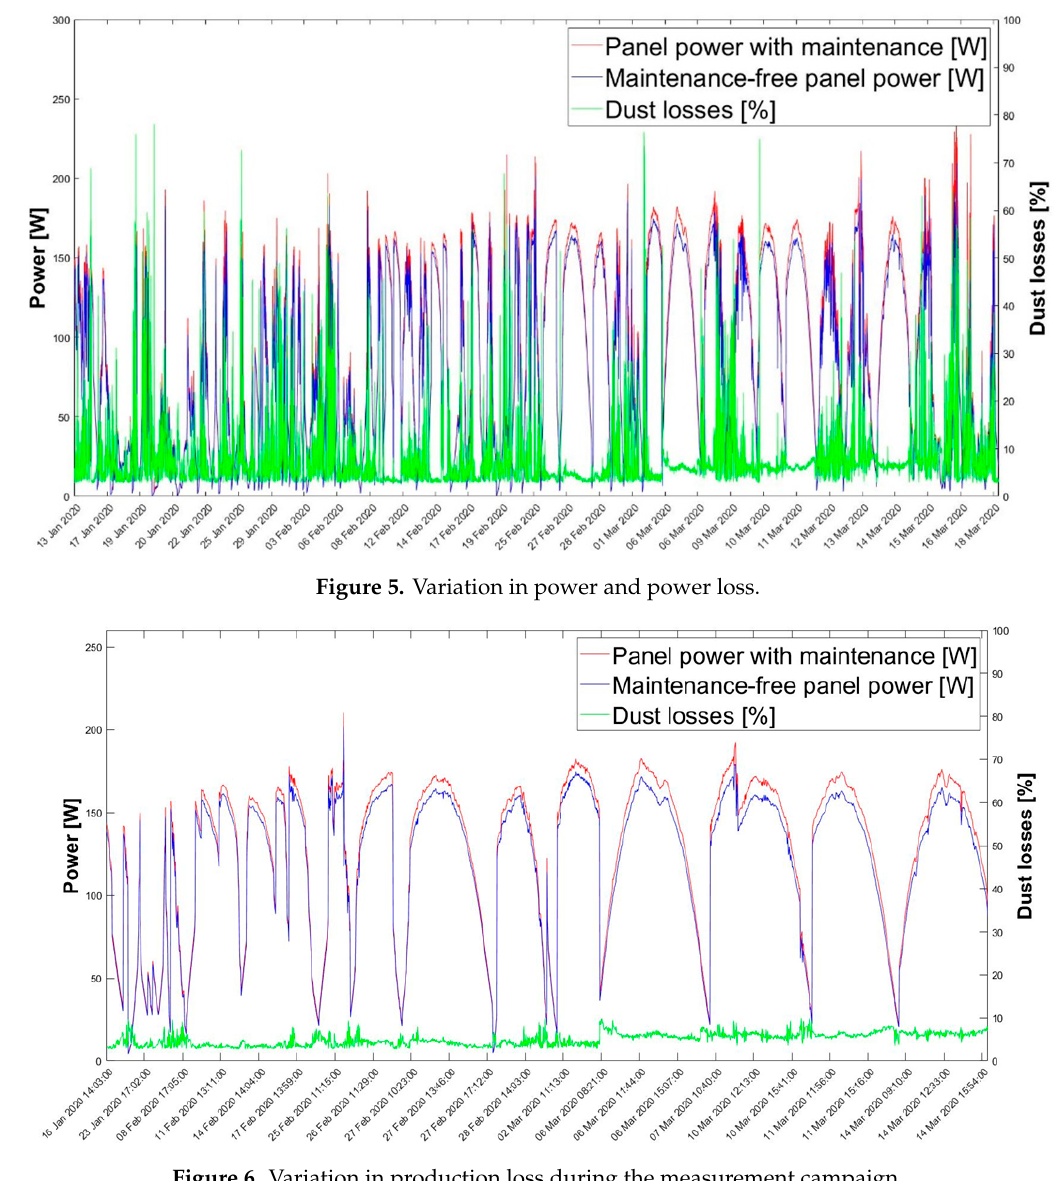
Figure 6. Variation in production loss during the measurement campaign. Table 4. Reduced production factor due to dust